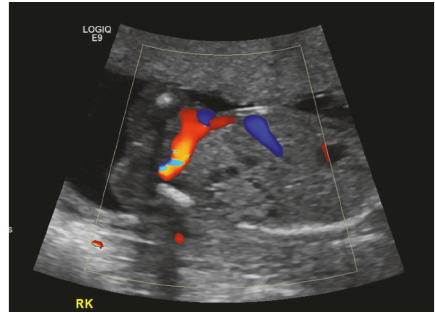
Figure 2: Multicystic dysplastic right kidney in the fetus at 19-week GA.